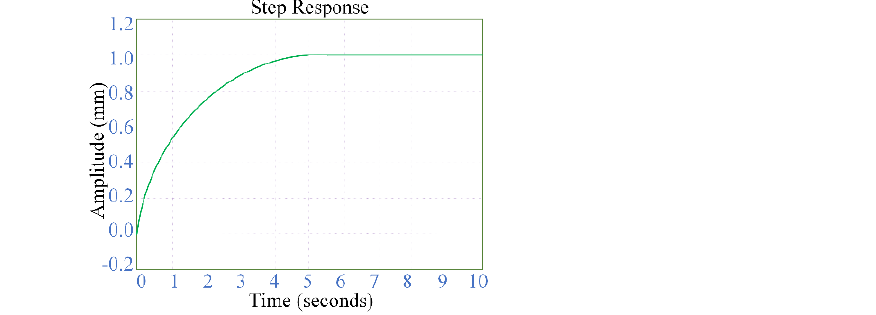
Figure 5. Step response curve of the EHS system after quadratic optimal control with linearity.